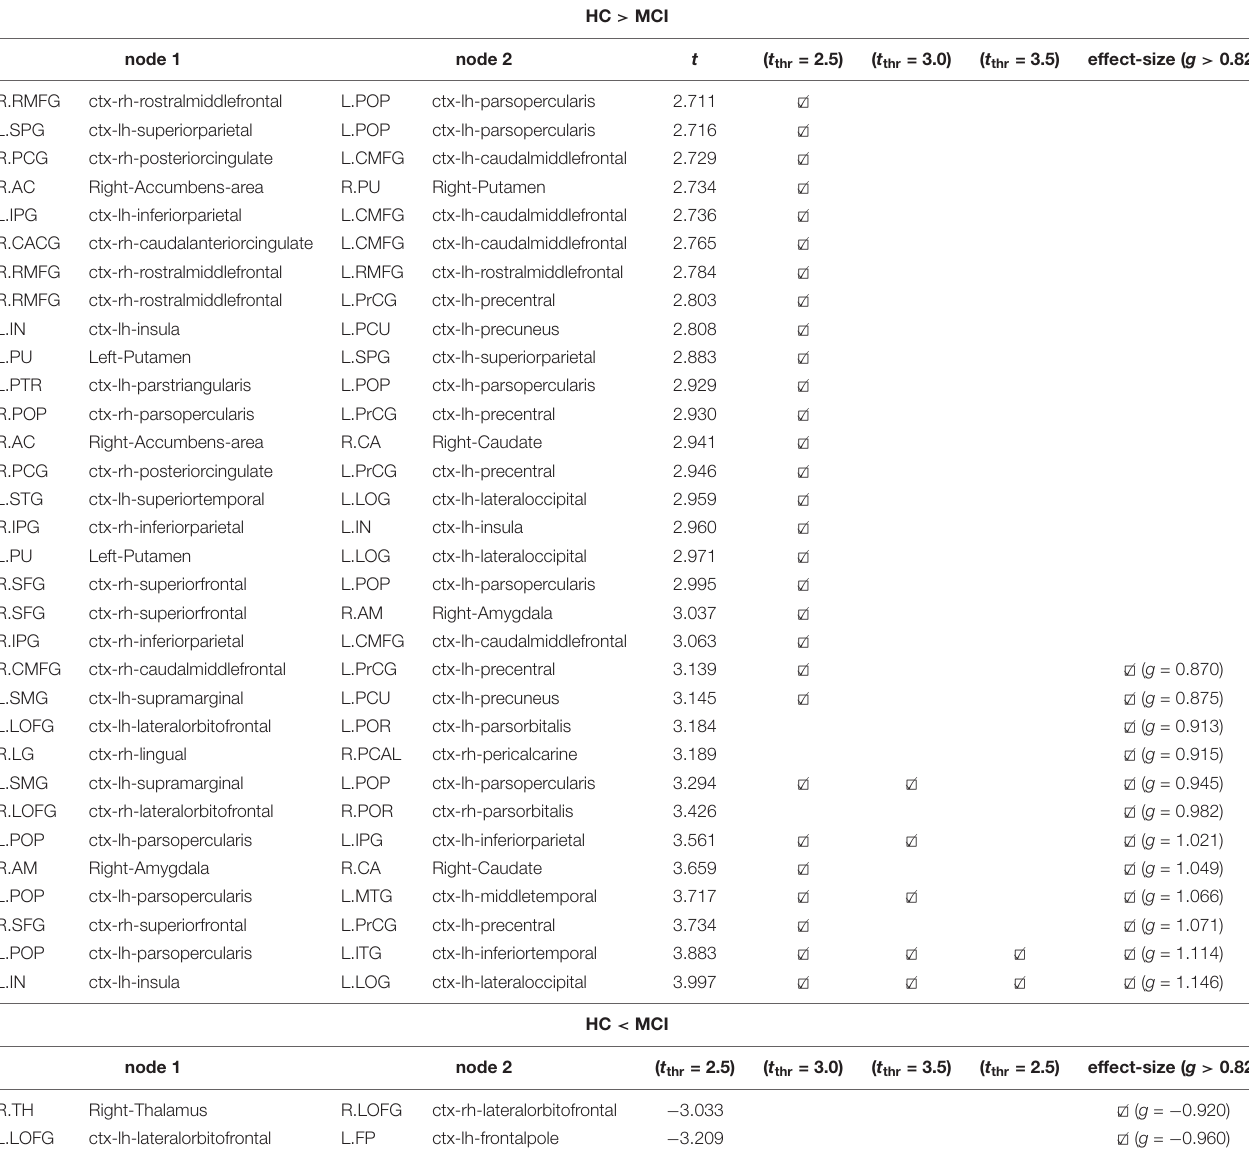
TABLE 4 | Connectivity results with NBS ( Figure 2 ) by different t thresholds: t thr = 2.5, t thr = 3.0, t thr = 3.5, and by the effect-size g > 0.82. HC > MCI node 1 node